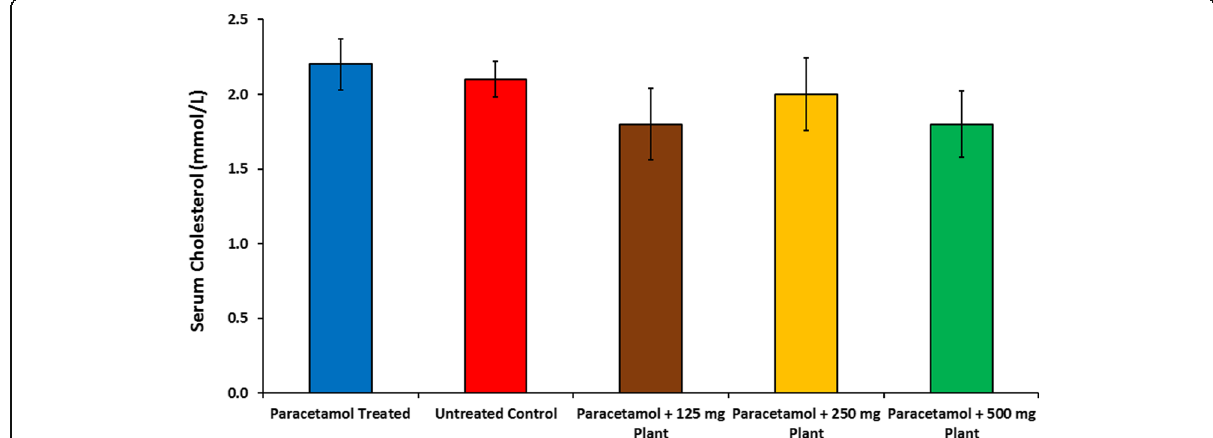
Fig. 3 Bar charts showing the effect of A. orientalis on serum cholesterol in paracetamol treated, untreated control, paracetamol A. orientalis